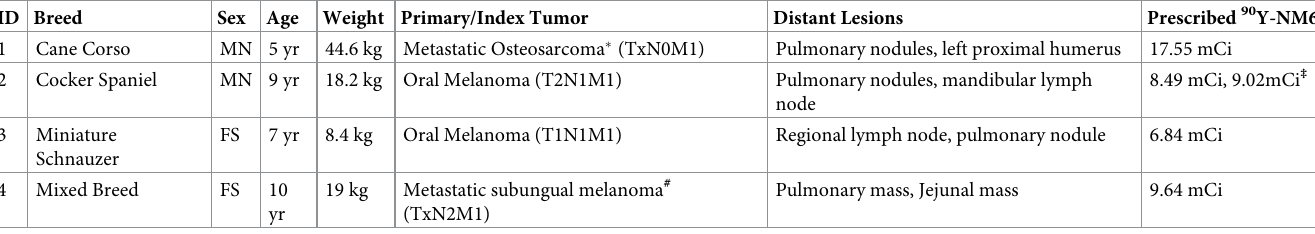
Table 2. Patient characteristics of dogs receiving EBRT/TRT/IT-IC combination